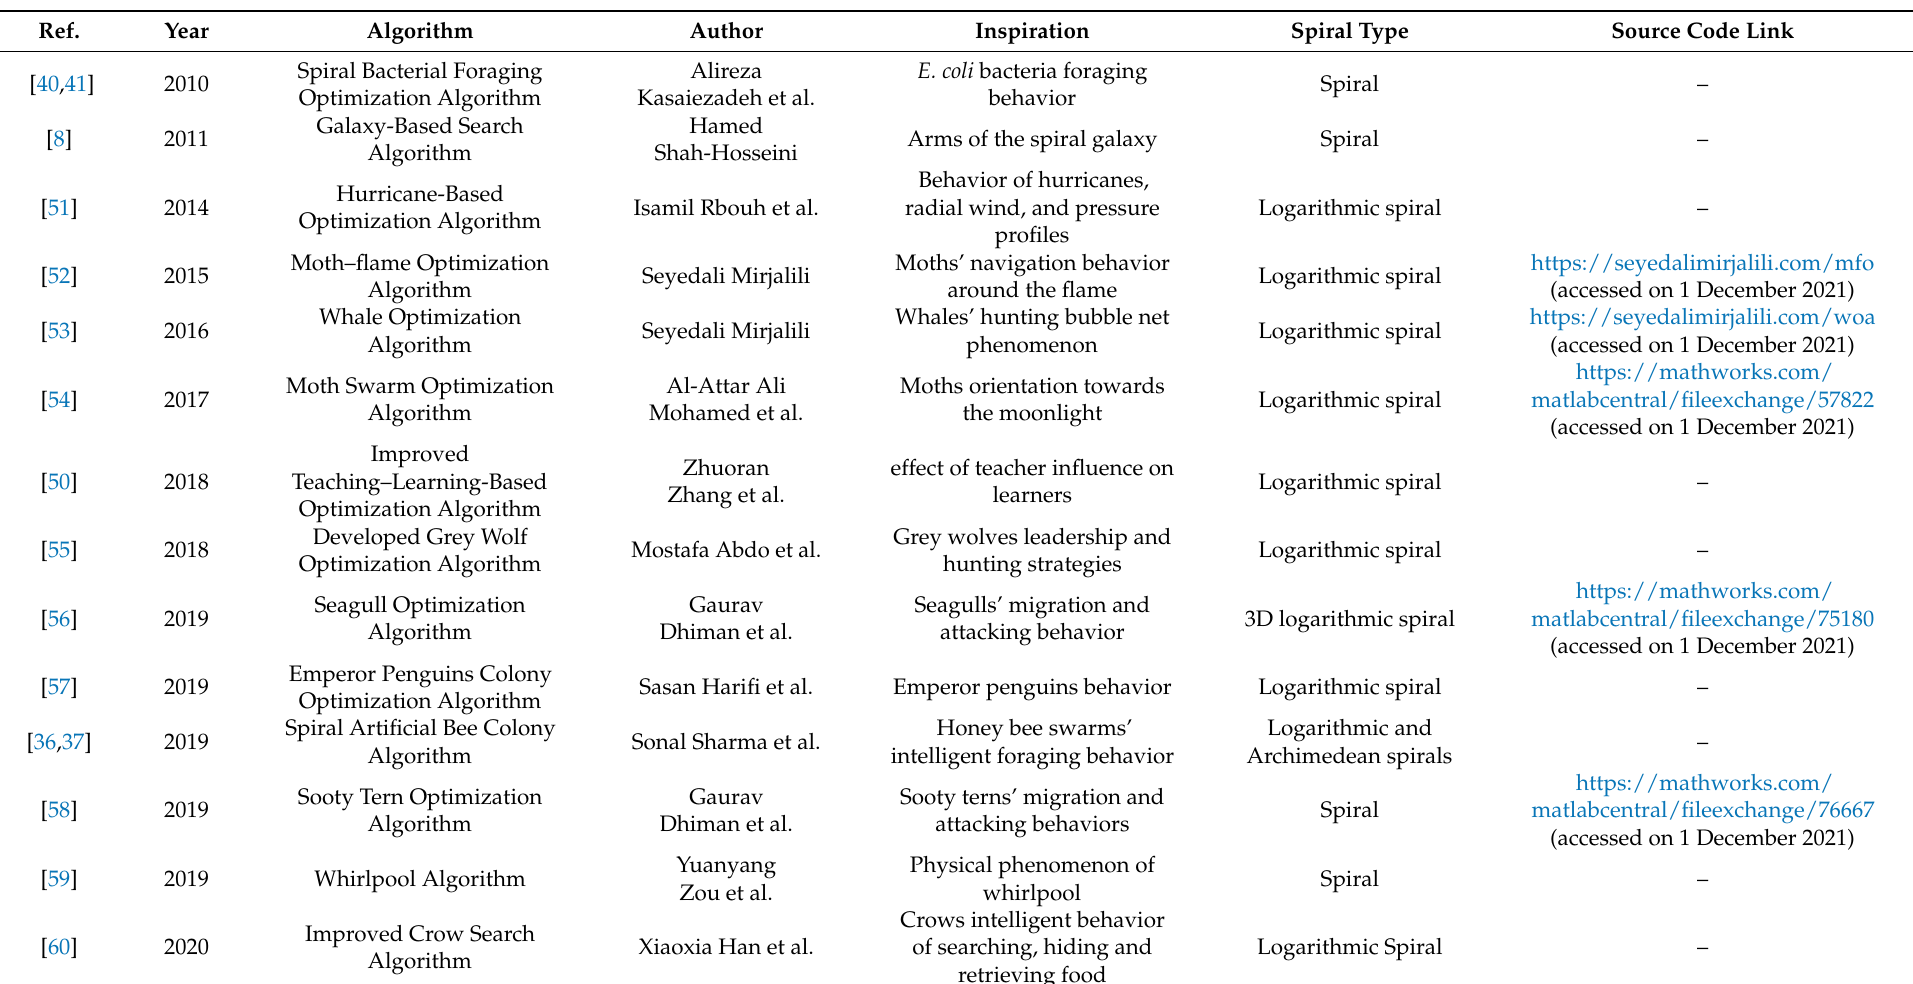
Table 1. List of spiral path-inspired optimization